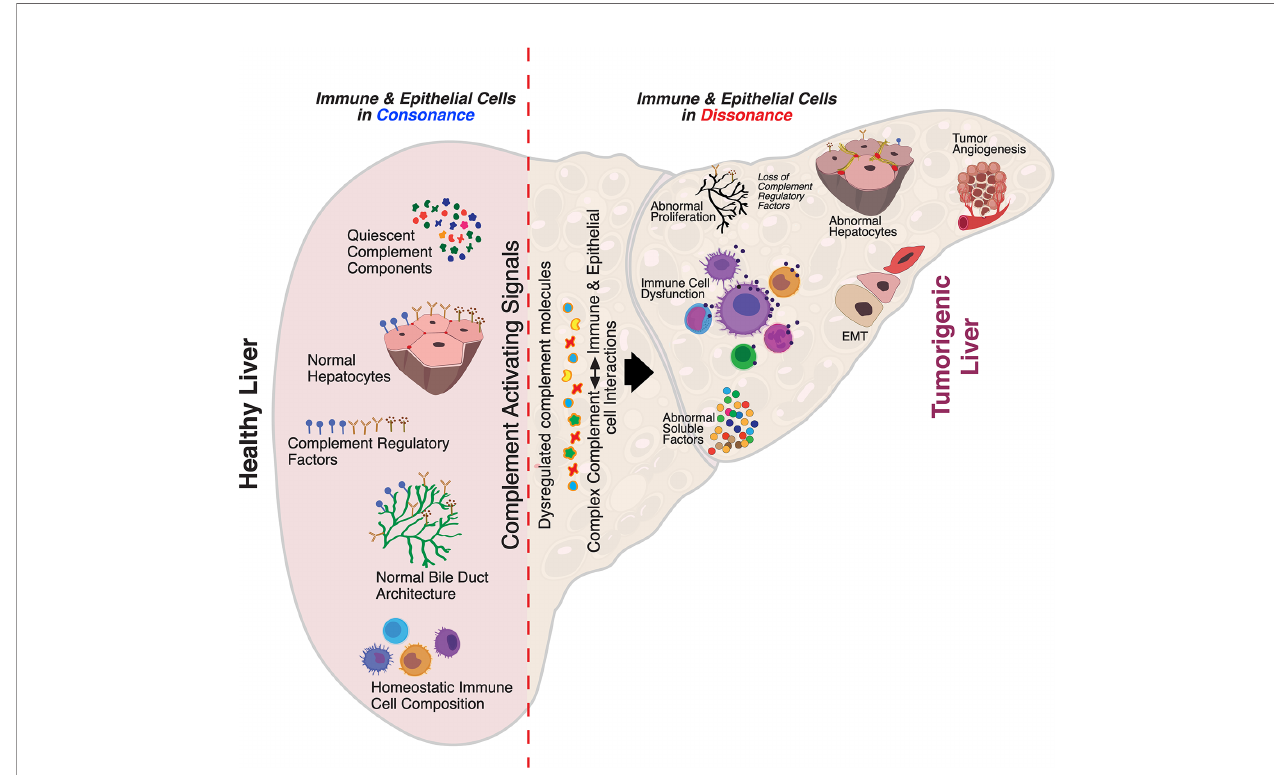
FIGURE 2 | Aberrant complement activation: a driver for disease progression in hepatocellular carcinoma. A schematic of the liver microenvironment depicting the transition of a healthy immunologically quiescent intrahepatic microenvironment to dysregulated immune status following activation cues to the complement system. In a healthy liver, immune and epithelial cells function in synergy to preserve normal architecture of bile ducts, quiescence of complement molecules, and homeostasis of immune cells. Complement activating disease-triggering signals orchestrate the evolution of dysregulated complement molecules (increased C3, C5, etc) and altered complement regulatory factors (CFH, etc). These acute and/or chronic sustenance of dysregulated complement molecules and their complex interaction with the immune and epithelial cell compartments drive the progression of hepatocellular carcinoma (HCC). Loss of complement regulatory factors and divergent activation of the complement system leads to abnormal hepatocyte architecture, deranged cellular and effector functions, and reactive bile duct pro fi les. Cumulatively, these events lead to epithelial to mesenchymal transition (EMT) and tumor angiogenesis which worsen the disease, resulting in poor clinical outcomes and